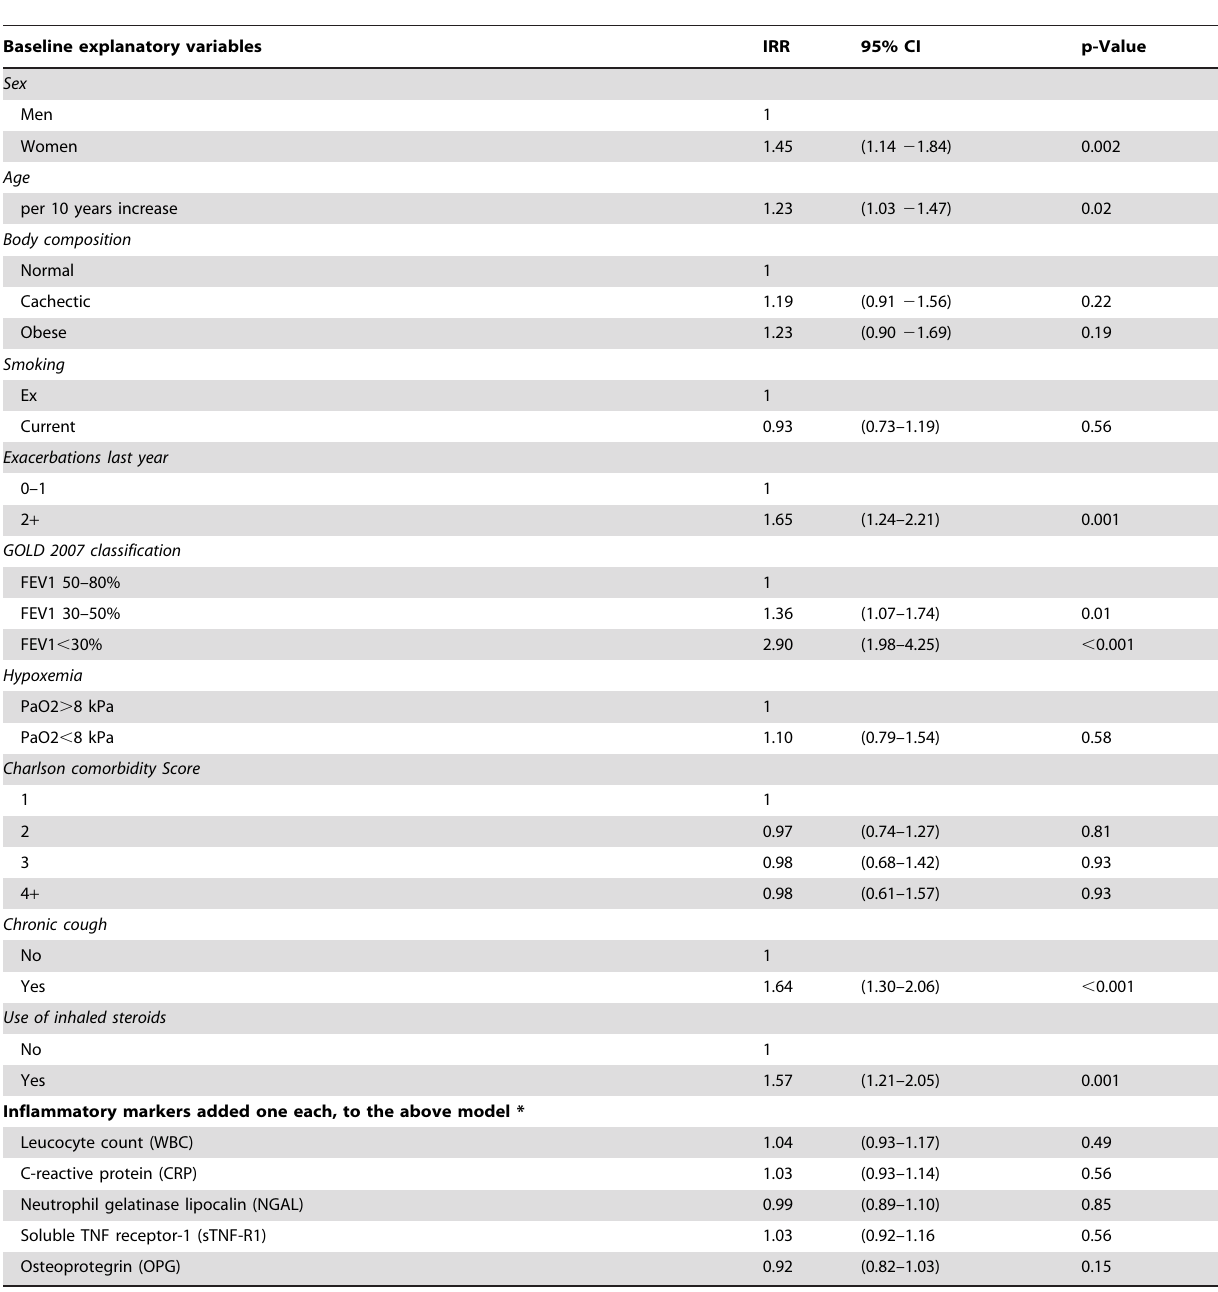
Table 3. Multivariate model of the annual incidence rate ratio (IRR) of moderate or severe COPD exacerbations, estimated by a random effects negative binomial